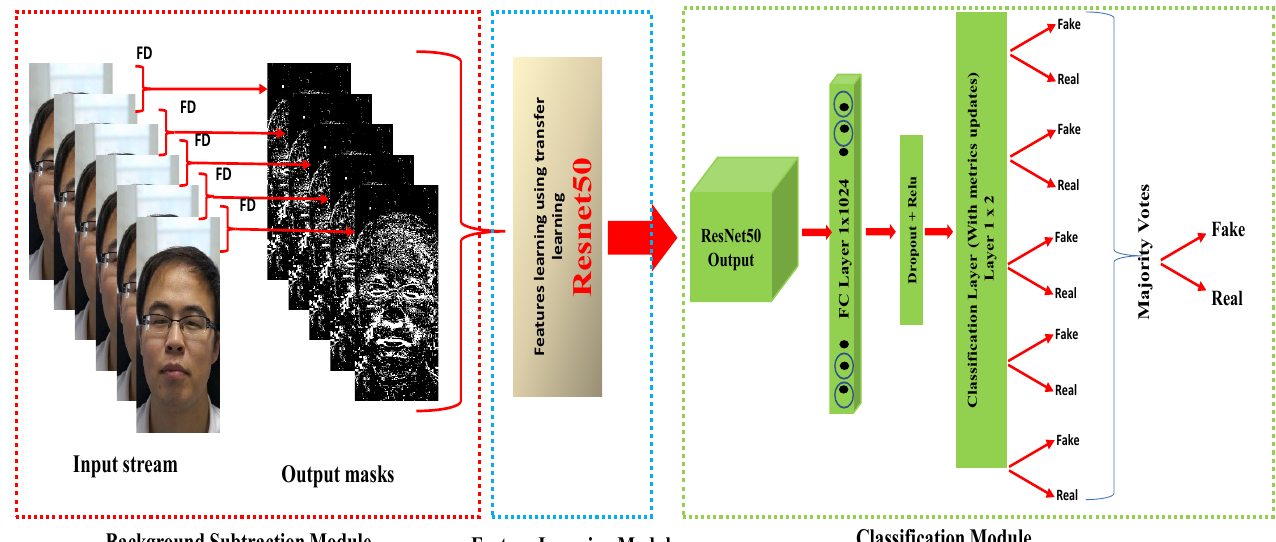
Figure 1. Framework of our proposed